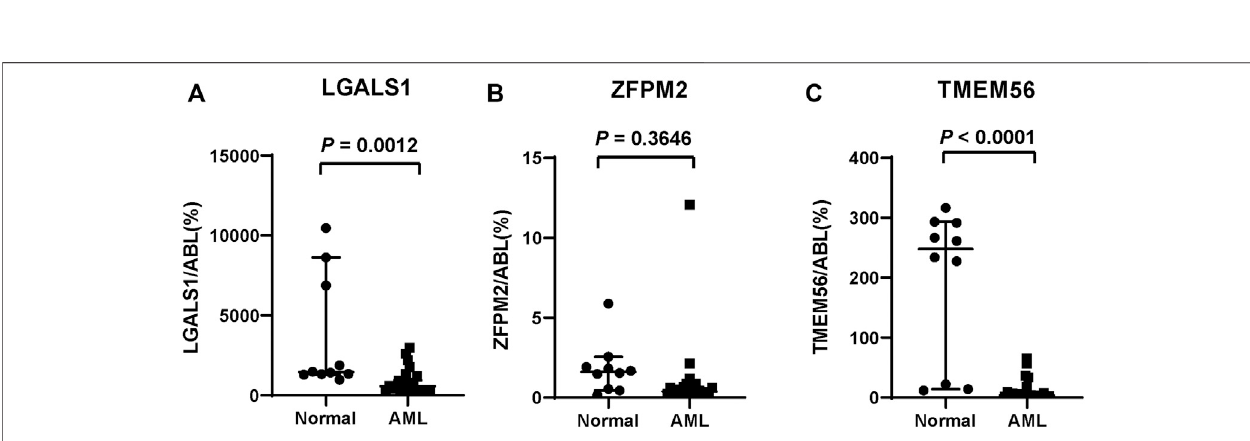
Frontiers in Cell and Developmental Biology |